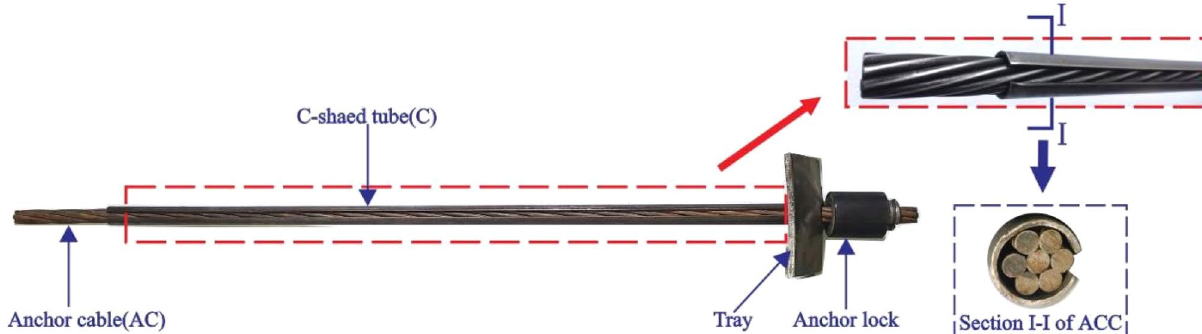
Figure 1. Structural composition of the